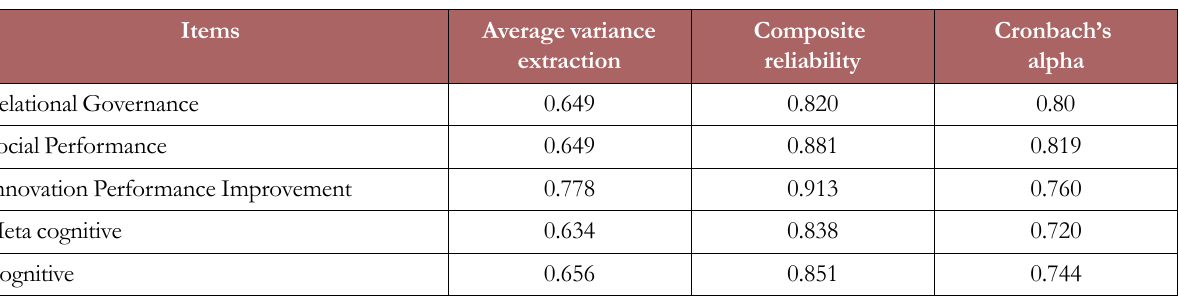
Table 3. Validity and Reliability of constructs Survey